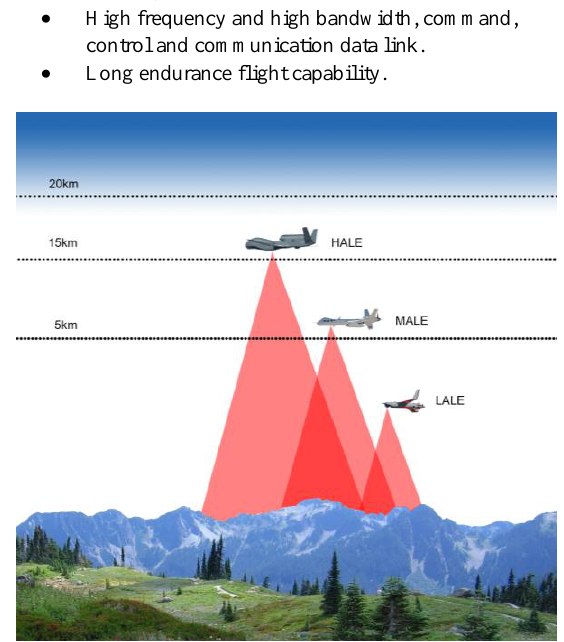
Figure 2 –Multiple UAS flight